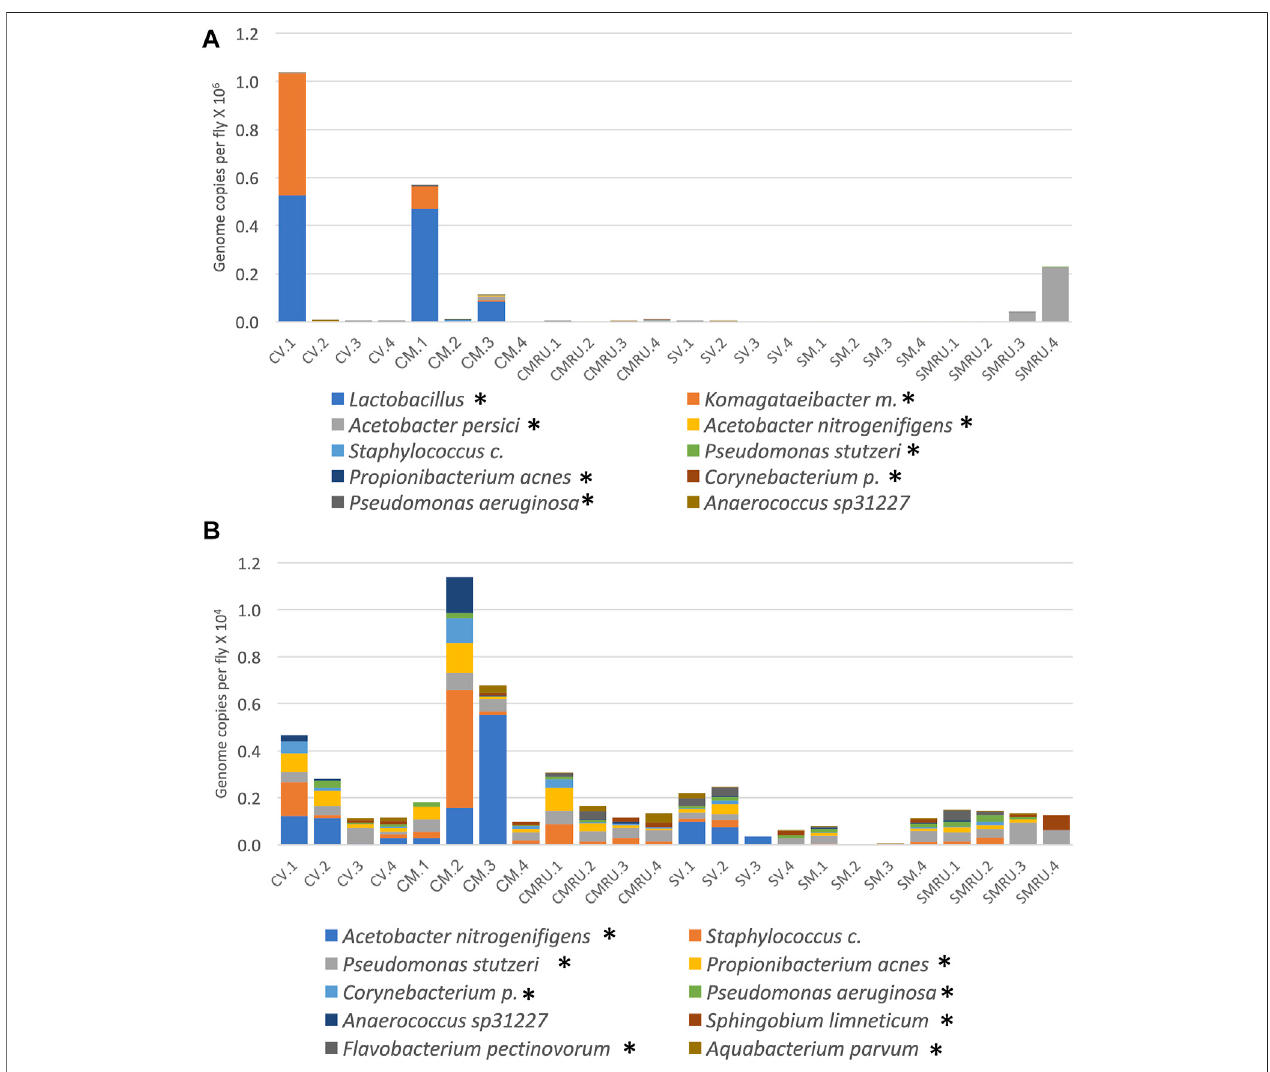
FIGURE 2 | Effect of sterilization and mifepristone on adult female bacterial species and identi fi cation of outliers. (A) Top 10 species, including outliers. (B) Top 10species, excludingoutliers.CV,controlvirgins;CM,controlmated;CMRU, controlmatedplus mifepristone/RU486;SV,sterilevirgins;SM,sterilemated; andSMRU, sterile mated plus mifepristone/RU486. Species and classes reported to be aero-tolerant are indicated with asterisk.